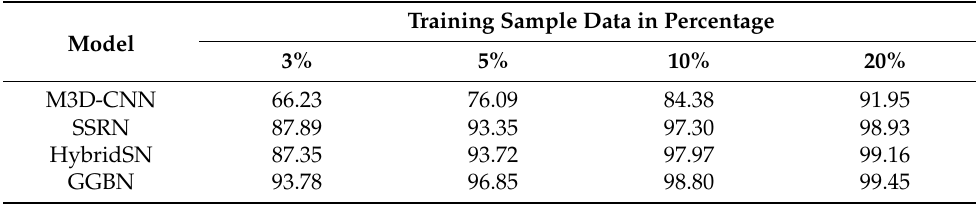
Table 5. Performance of the selected models on varied training sample data over IP dataset.